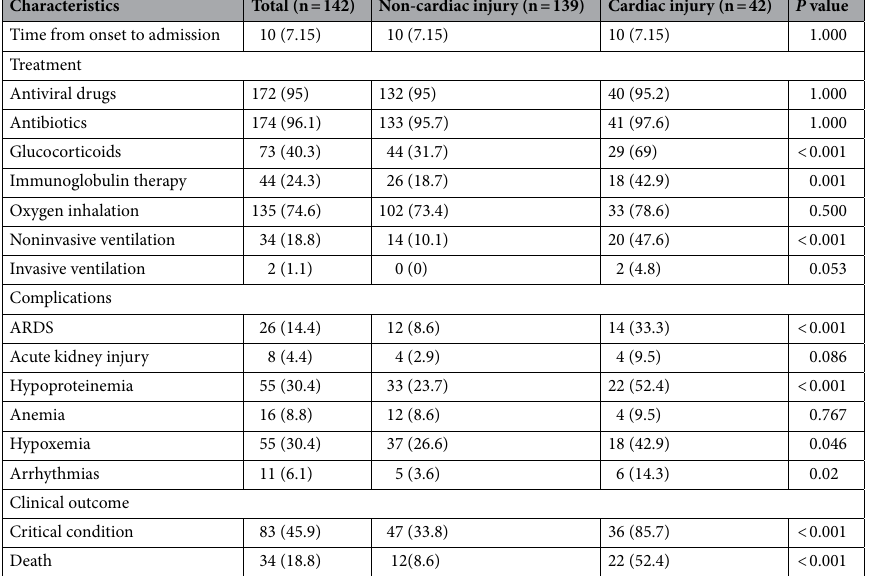
Table 2. Treatment, complications and clinical outcome of patients with COVID-19.